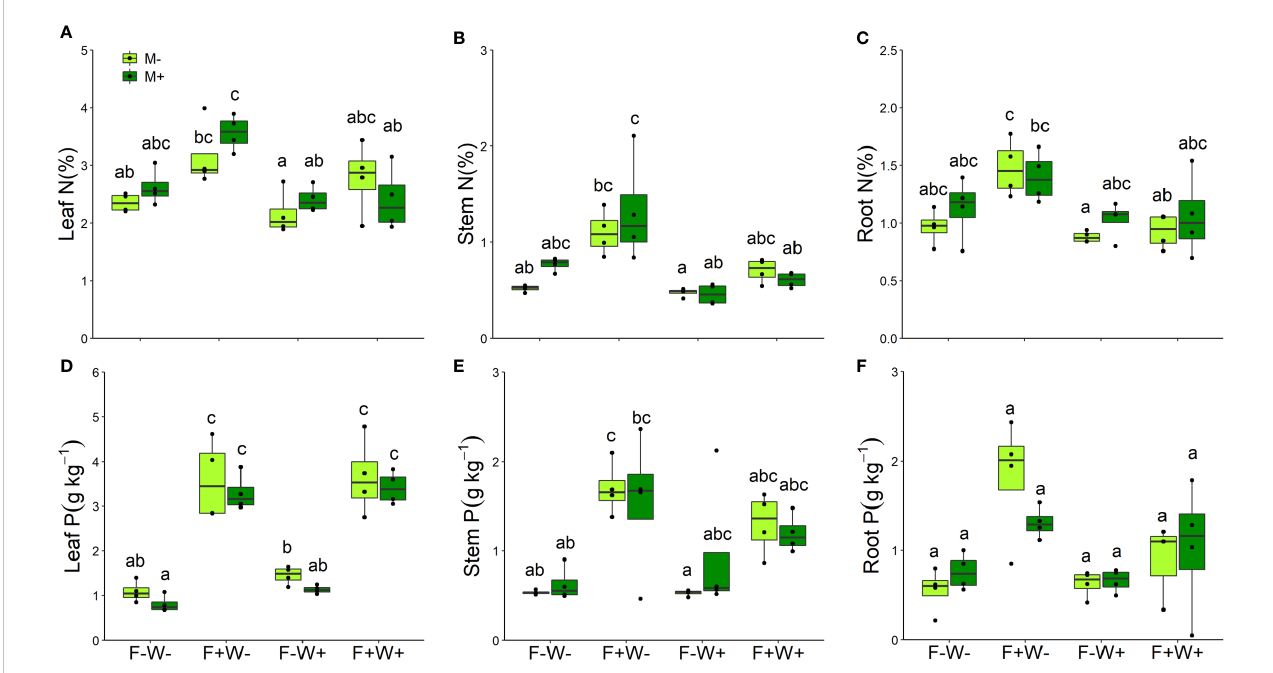
FIGURE 5 Nitrogen (A – C) and phosphorus (D – F) concentrations of different plant tissues of Artemisia ordosica that were inoculated with the AM fungal species Funneliformis mosseae (M+) or not (M-) and grown under four different combination of fertilization (F-: no fertilization; F+: fertilization) and water addition (W-: low soil water; W+: high soil water) treatments. Light symbols: plants received no AMF; dark symbols: plants inoculated with AMF Funneliformis mosseae . The boxplot shows the 25% and 75% quartiles, the median, whiskers (1.5 times the interquartile range) and the outliers of the samples, and the points in the plot area represent different replicates of the corresponding treatment. Boxplots sharing one or more identical letters are not signi fi cantly different based on Tukey ’ s post hoc test. Statistics are shown in Table 2.